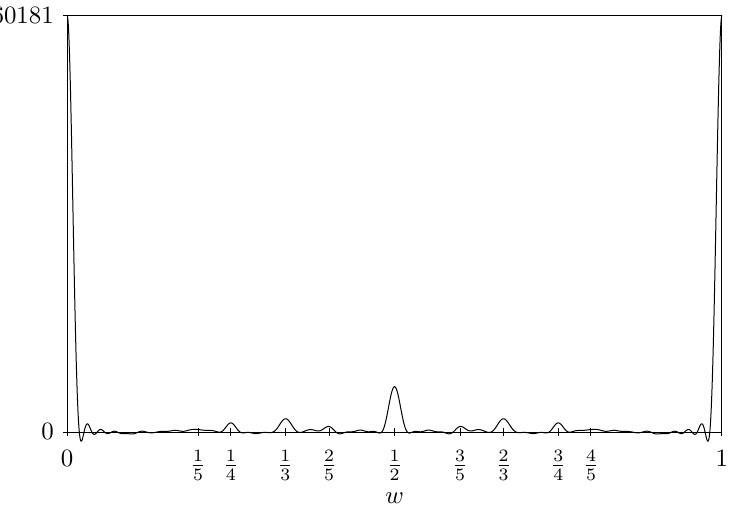
Figure 6 . The circle method integrand with c = 3 , r = 10 , and ‘ = 0